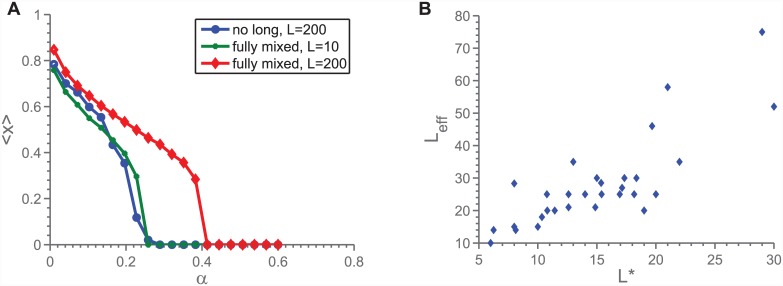
a) Comparison of finite size effects to clustering effects. b) Scatter-plot of Leff vs. L* (defined in Eq (6)). We see an approximatively linear relation. In sum, we see a good evaluation of the finite-size explanation of the topology dependence in 〈x〉 vs. α.